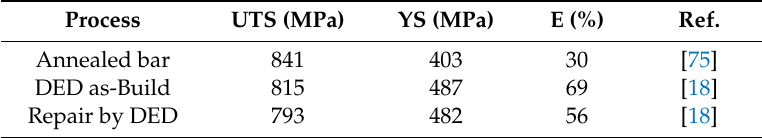
Table 3. Mechanical properties of manufactured or remanufactured Inconel ®